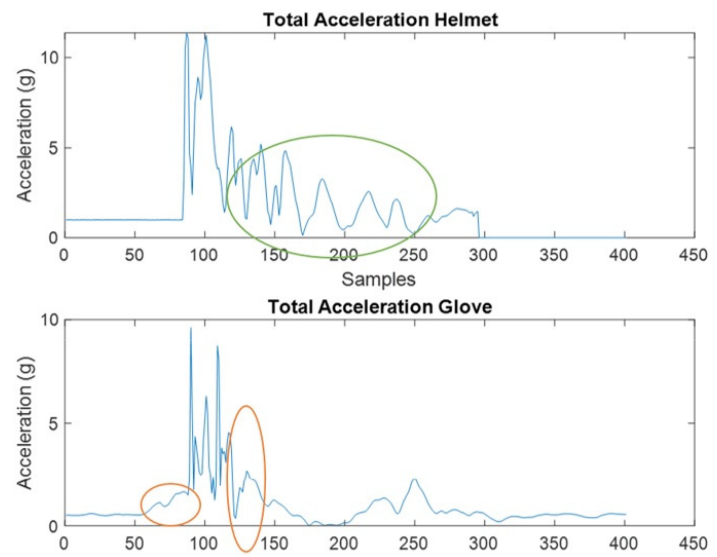
Figure 5. This figure shows the total acceleration of the helmet vs. the glove. Green circled area represents the cyclic motion of B.O.B as it oscillates after the punch while the orange circled areas represent the hand motion captured in the punches.